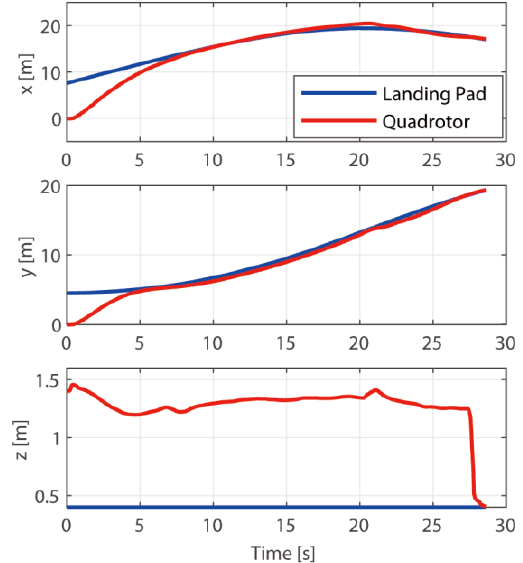
Figure 10. Trajectory of quadrotor in case 2. ( a ) Trajectory with Gaussian noise with a standard deviation of 0.01. ( b ) Trajectory with Gaussian noise with a standard deviation of 0.5. ( c ) Trajectory with Gaussian noise with a standard deviation of 1.0.